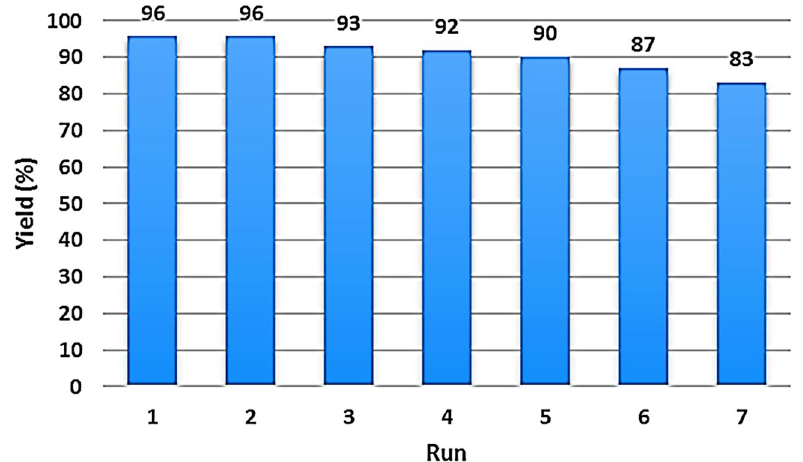
Figure 7. Reusability of the MS/Ag 2 CO 3 nanocatalyst.